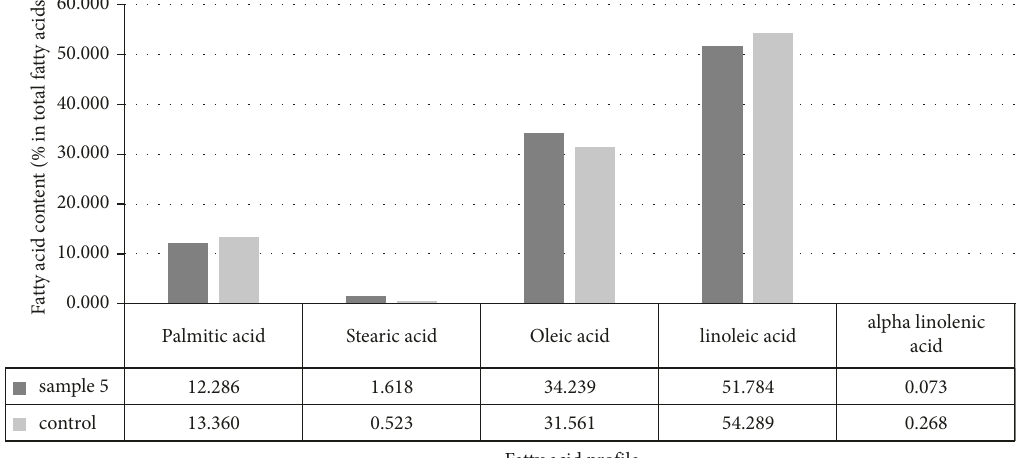
Figure 6: Comparison of fatty acid profile of treatment No.5 (Selected treatment) with control sample. The fatty acid profile was determined through gas chromatography (GC-FID). There was not much positive differences betweenthe amounts of T5 essential fatty acids with control sample.